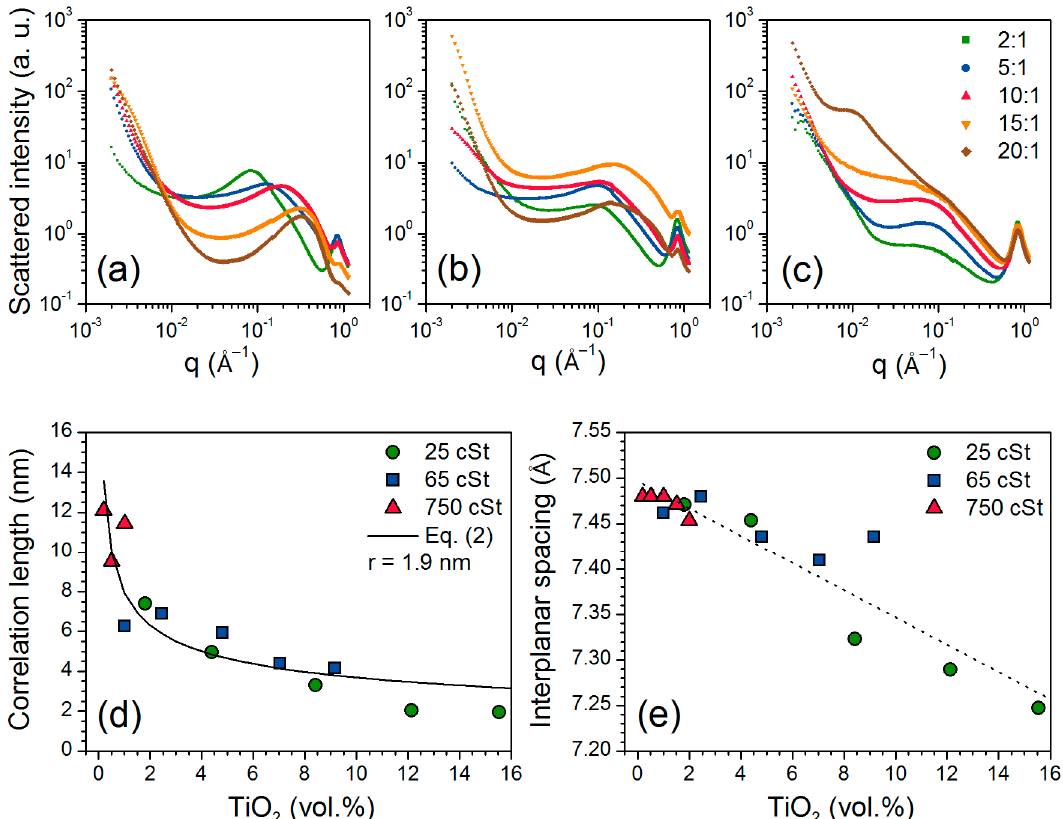
Figure 5. SAXS profiles ( λ = 1.0332 Å) of mould-casted Ti-PDMS hybrid films prepared using PDMS-OH with viscosities of ( a ) 25 cSt, ( b ) 50 cSt and ( c ) 750 cSt for different TIP/PDMS-OH molar ratios. ( d ) Correlation length of titania-like inorganic amorphous nanodomains with fitting to Equation (2) and ( e ) interplanar spacing of the PDMS amorphous halo as a function of the TiO 2 vol. % with linear regression.